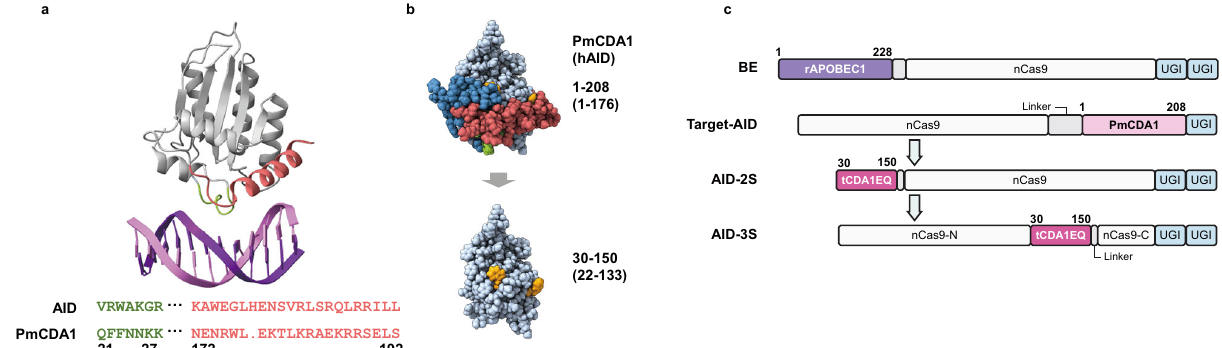
Fig.1|Rationalengineeringofsmallerandspeci fi cTarget-AID.a Ribbonmodel of the structure of a complex of human AID with dsDNA. The non-catalytic dsDNA binding domain is shown in green (N-terminus) and red (C-terminus), of which amino acid sequences are aligned with that of PmCDA1 at the bottom. b The pre- dicted space- fi lling structure of PmCDA1 before and after engineering. In addition